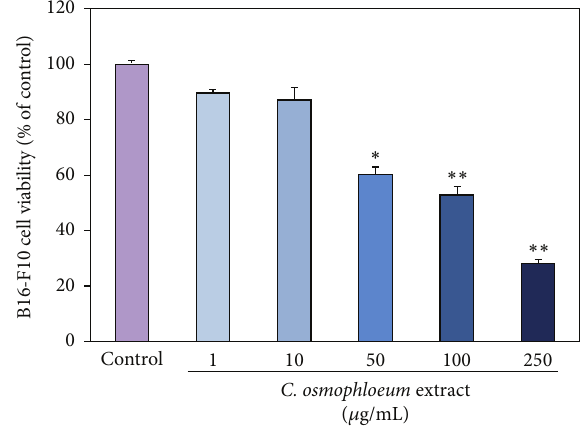
Figure 2: The cytotoxicity of C. osmophloeum Kanehira extracts on marine melanoma B16-F10 cells. Data: the mean value ± SD (triplicate values for three independent experiments); ∗ < 0.01 , ∗∗ < 0.001